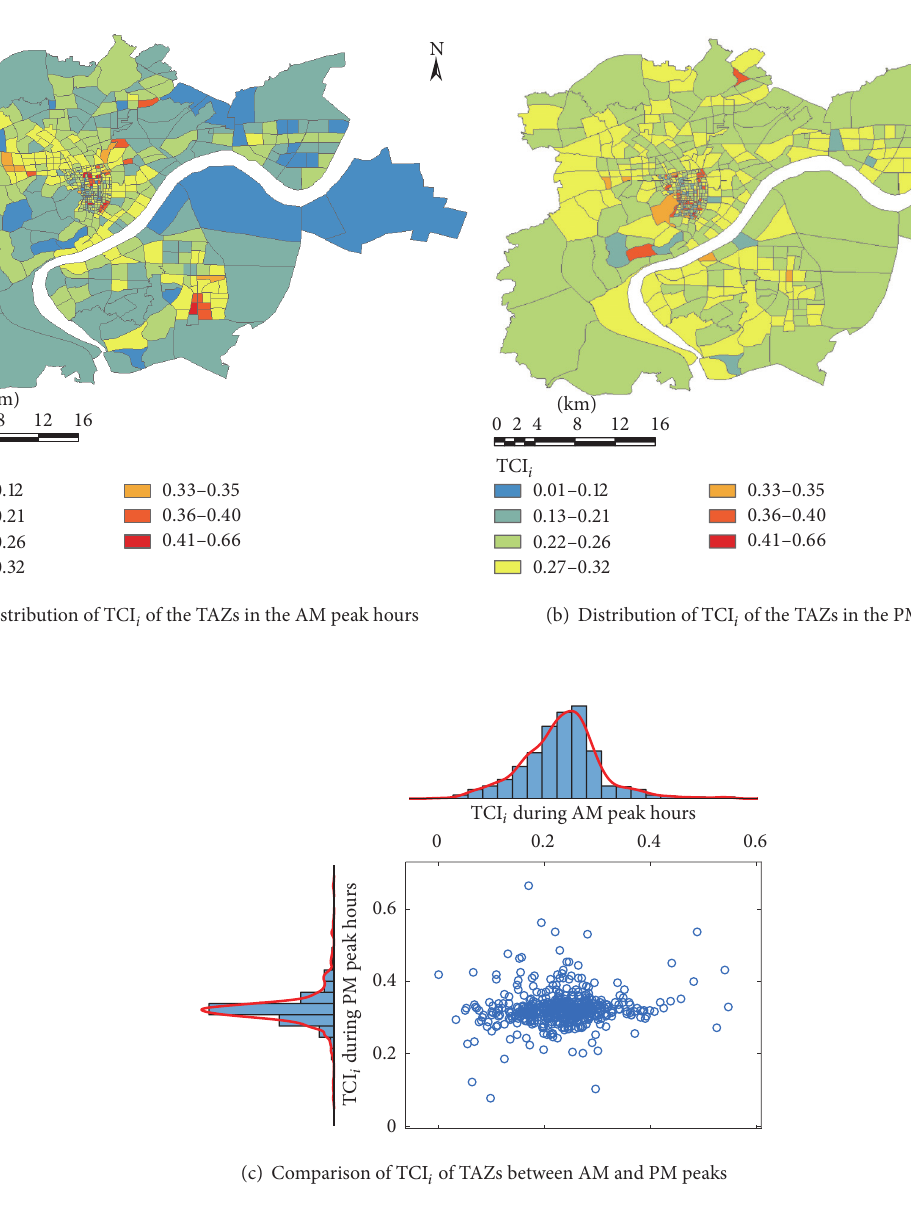
Figure 7: Distributions of TCI of TAZs during peak hours ( 𝑑 = 1000m, 𝛼 =